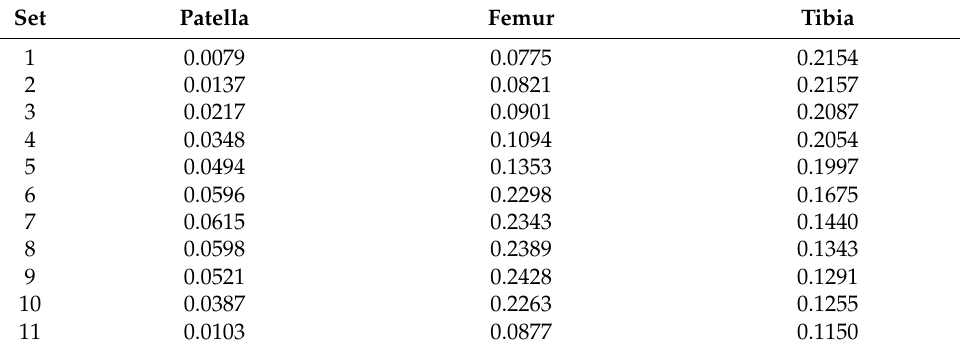
Table 3. Normalized area values due to the size of the knee on the transverse plane.